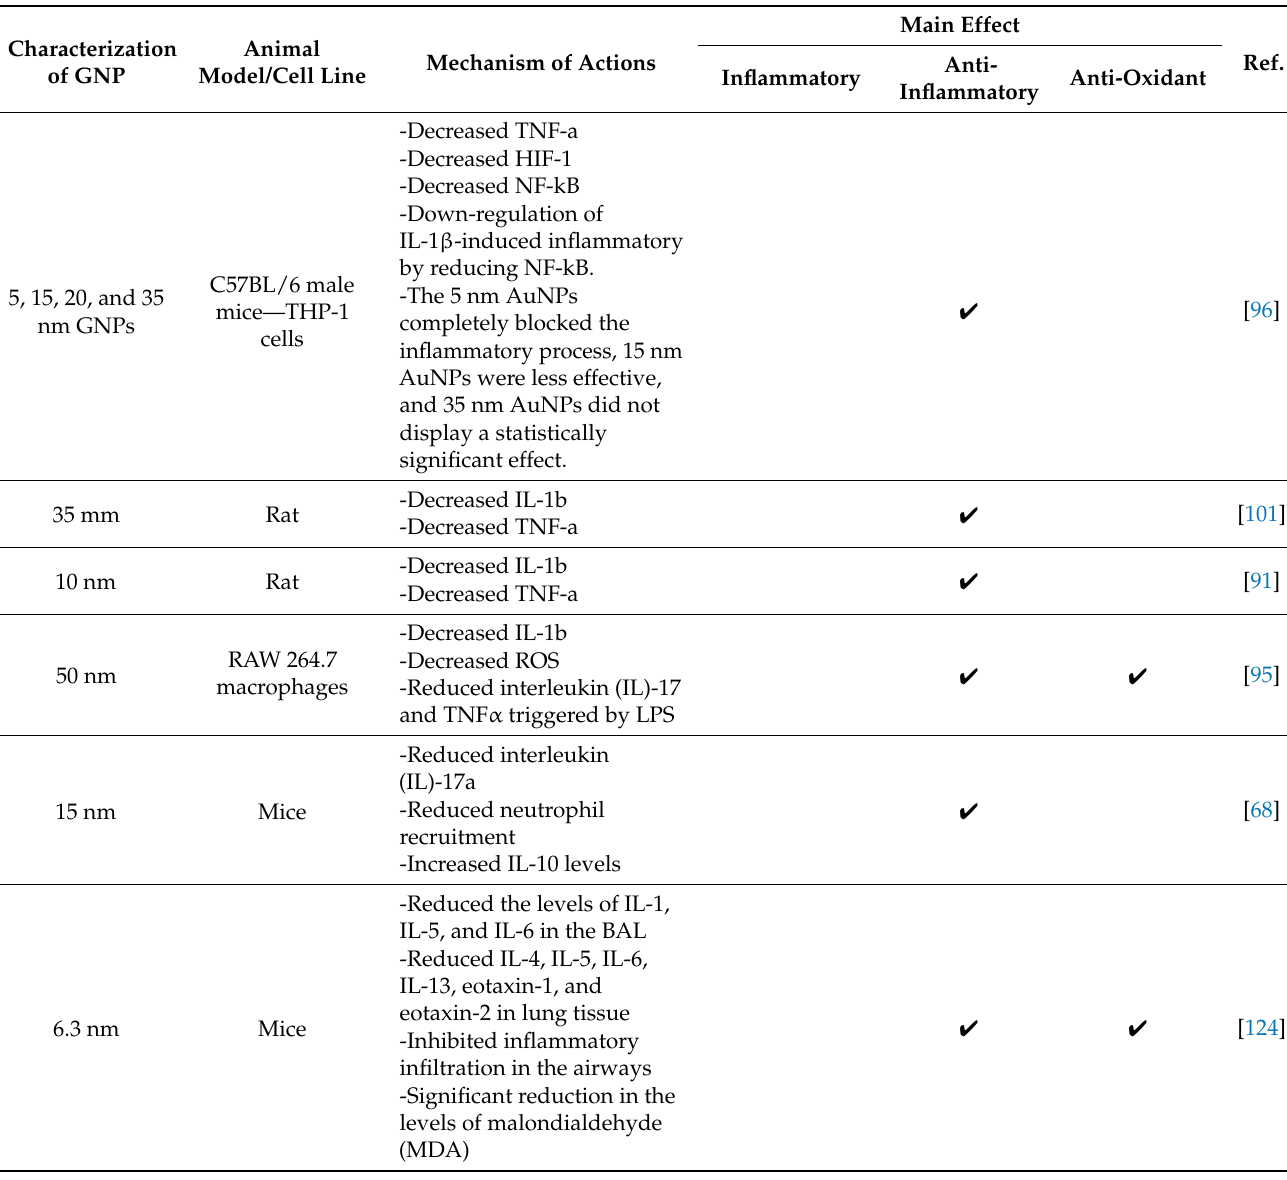
Table 1. The effects of bare GNPs on the production of inflammatory and oxidant parameters.